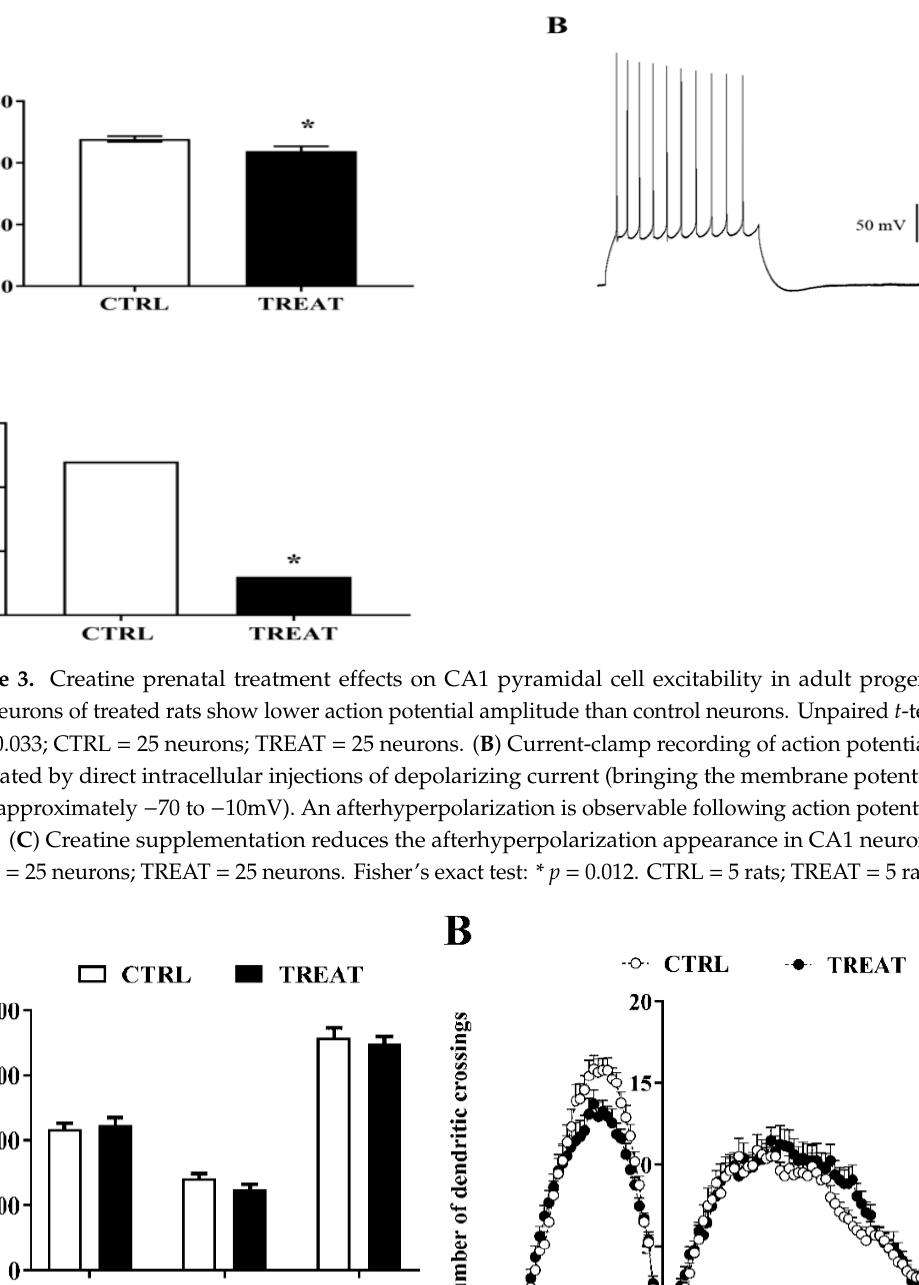
7 of 13 Figure 2. Creatine maternal supplementation affects input resistance in adult CA1 neurons . Neurons of treated rats excited by current injections above 150 pA do not show differences in input resistance compared to treated neurons excited by current injections below 150 pA, while such differences were found in neurons of control rats. Two-way ANOVA with Intensity of stimulation and Treatment (CTRL vs TREAT) as independent variables while the litter was considered as a blocking factor; Intensity : F (1, 42) = 14.69 p = 0.0004; >150 pA CTRL: n =11 neurons; TREAT: n = 11 neurons; <150 pA CTRL: n = 14 neurons; TREAT: n = 11 neurons. Sidak’s multiple comparisons test: <150 pA CTRL vs. >150 pA CTRL p = 0.0116. CTRL = 5 rats; TREAT = 5 rats. Analyzing the amplitude of CA1 neuron action potential, we found that it was significantly lower in the creatine-treated group compared to controls. Moreover, only 12% of these neurons showed an afterhyperpolarization (AHP) following spike burst induction, in comparison to 48% detected in the control group (Figure 3A–C). This result would support the improvement in LTP